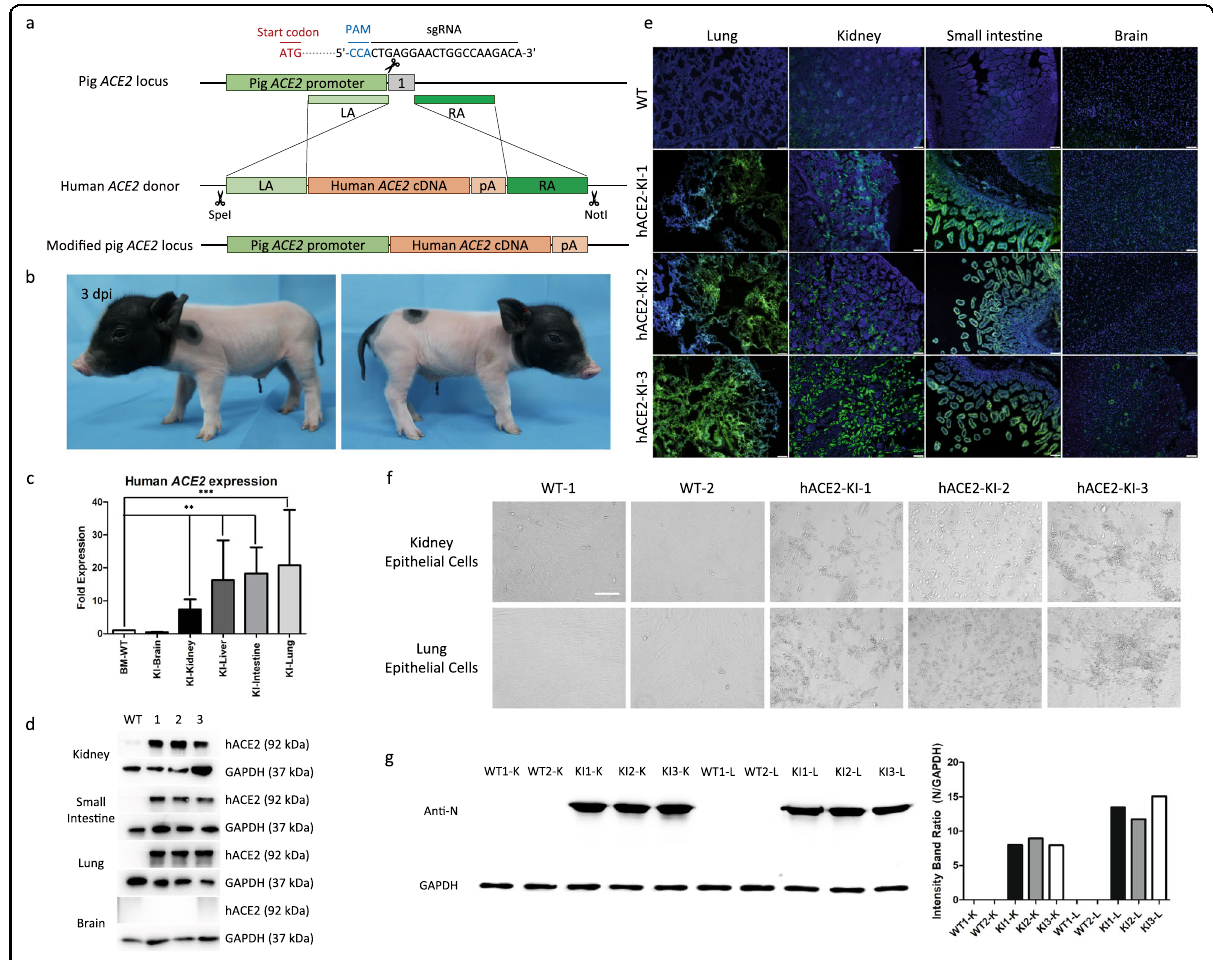
Fig. 1 Generation and characterization of a site ‑ speci fi c hACE2 knock ‑ in pig model for COVID-19. a Scheme for hACE2 integration in porcine fetal fi broblasts (PFFs) via CRISPR/Cas9-mediated homology-directed repair. b The physical appearance of representative cloned piglet. c Transcriptional analysis of hACE2 in cloned pigs showing mRNA expression levels of hACE2 in different tissues. Total RNA in different tissues of WT and knock-in pigs was extracted and subjected to reverse transcription, followed by qPCR to determine the expression of hACE2 , with GAPDH as an internal reference gene. Data are presented as mean ± SD and are plotted from three independent experiments. ** P < 0.01, *** P < 0.001, n = 3, unpaired one-tailed Student ’ s t -test. KI, knock-in. d Western blot showing expression of hACE2 protein in WT and knock-in (1, 2, 3) piglets. kDa, kilodalton. e Localization of hACE2 protein (green) in the lung, kidney, small intestine, and brain of WT and knock-in piglets indicated by immuno fl uorescent analysis. Nuclei are stained with DAPI (blue). Representative images were randomly chosen. Scale bars, 50 μ m. KI, knock-in. f Primary epithelial cells of hACE2 knock-in piglets showed signi fi cant cytopathic effects after SARS-CoV-2 infection. Scale bars, 50 μ m. KI, knock-in. g Western blot analysis for the expression of virus N protein in primary epithelial cells derived from WT and knock-in piglets. K, kidney epithelial cells; L, lung epithelial